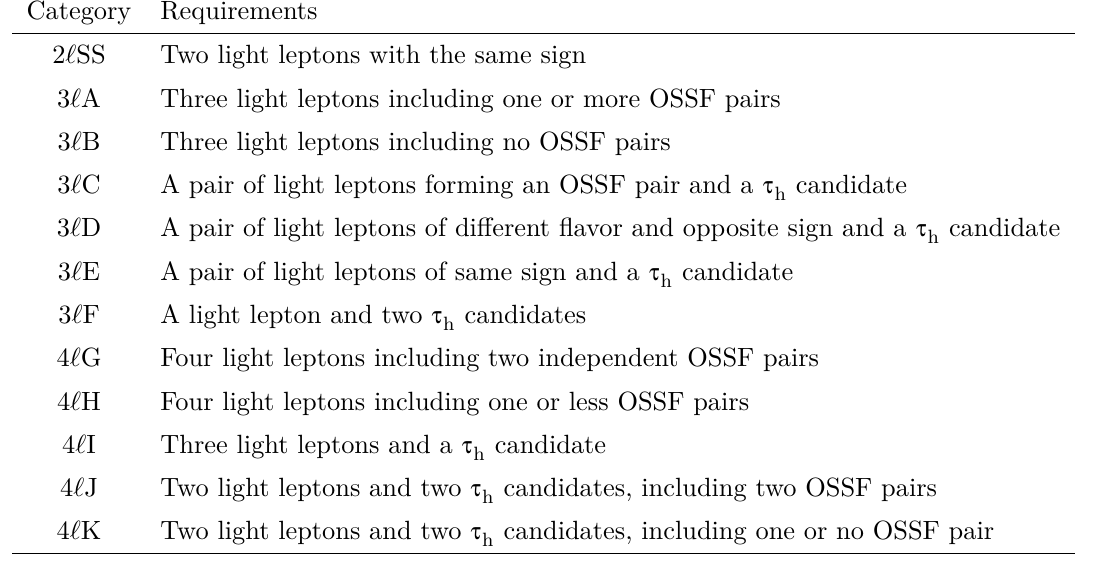
Table 1 . Brief description of the categories used to classify events in the